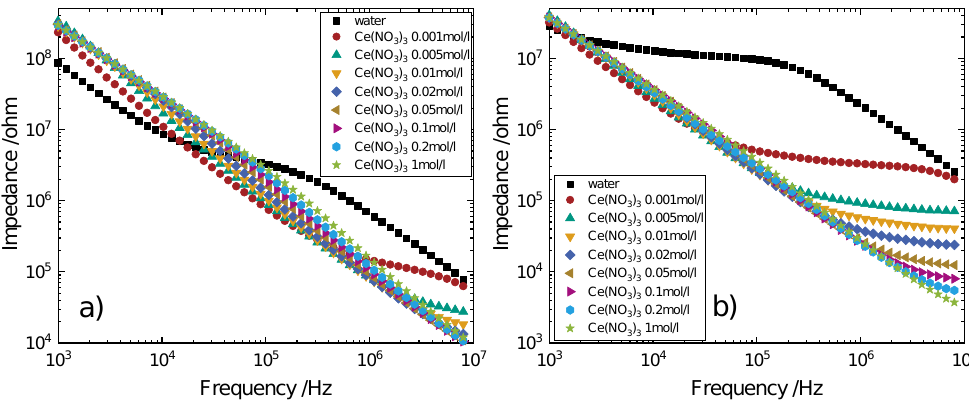
Figure 5. Impedance over frequency for deionized water and cerium nitrate with different concentra- tions. ( a ), Geo1 (5 mm distance, 5 mm width) and ( b ), Geo9 (20 mm distance, 20 mm